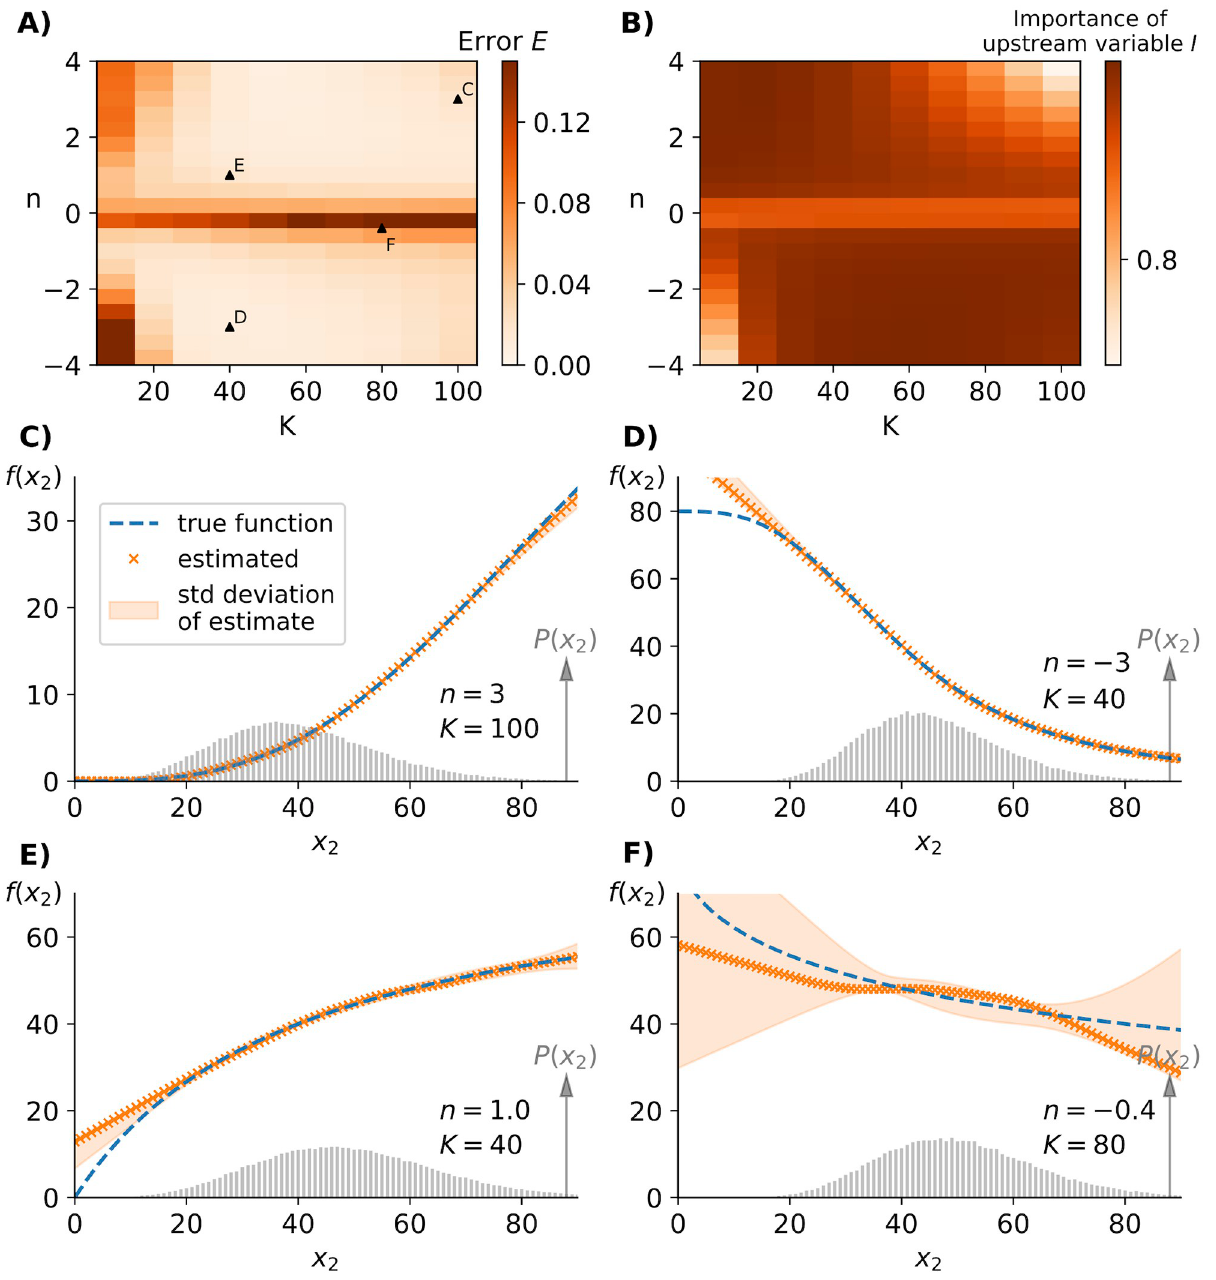
Fig 4. Different shapes of rate functions can be inferred. A) Changing the shape of the production rate f ð x while keeping time-scales fixed and equal, we find that the inferred reaction rates using Eq (4) and P ( x 2 , x 3 ) agree well with the true rate for N = 100, 000 samples across a broad range of the parameter regime. Data shown are for the same noise enhancing three-component system (Materials & methods) as in Fig 3. B) Unsatisfactory inference of f ( x 2 ) corresponds to regimes in which the upstream variable has only little influence on the downstream fluctuations as quantified by the relative importance term I defined in Eq (6). C,D,E) Successful inference examples for different Hill-functions including repressing effects of X 2 on X 3 . Any deviations from the true rate function are in the region in which the system is rarely or never observed. F) Example of unsatisfactory inference when the reaction rate varies only little over the majority of observed states resulting in a small effect of X 2 - fluctuations on X 3 -levels. The poor inference is also highlighted by the extremely broad shaded region indicating the standard deviation of inferred f ( x 2 ) for identical systems subject to different random sampling.